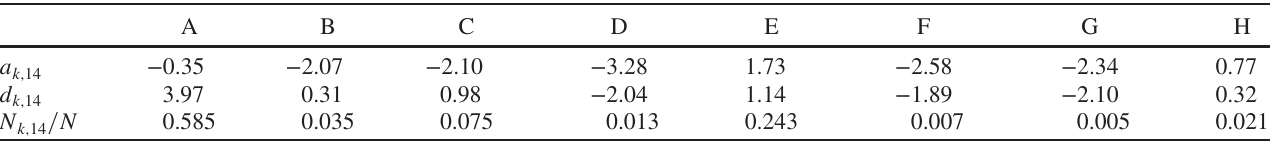
TABLE I. The set of a and d parameters for item 14 of the FMCE calculated from our dataset. These values are the average of k;j k;j 10 000 repeated analyses with randomly generated starting values. The final row is the fraction of our dataset that gave each response: N is the number of students who chose response k for item j , and N is the total sample size (22 263). k;j